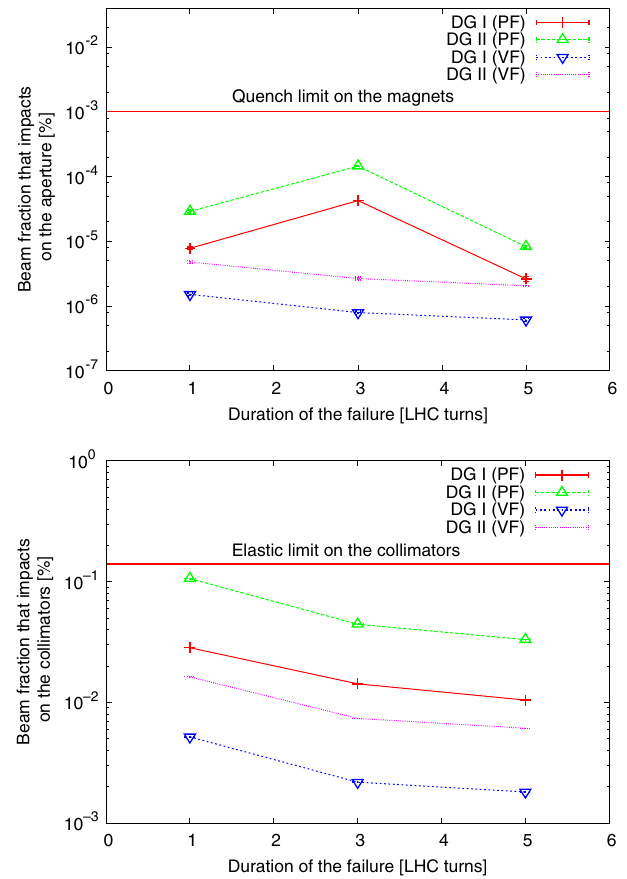
FIG. 11. Beam fraction that impacts on the aperture (top) and collimators (bottom) considering the different failure cases in voltage and phase for DG I and DG II. Errors are